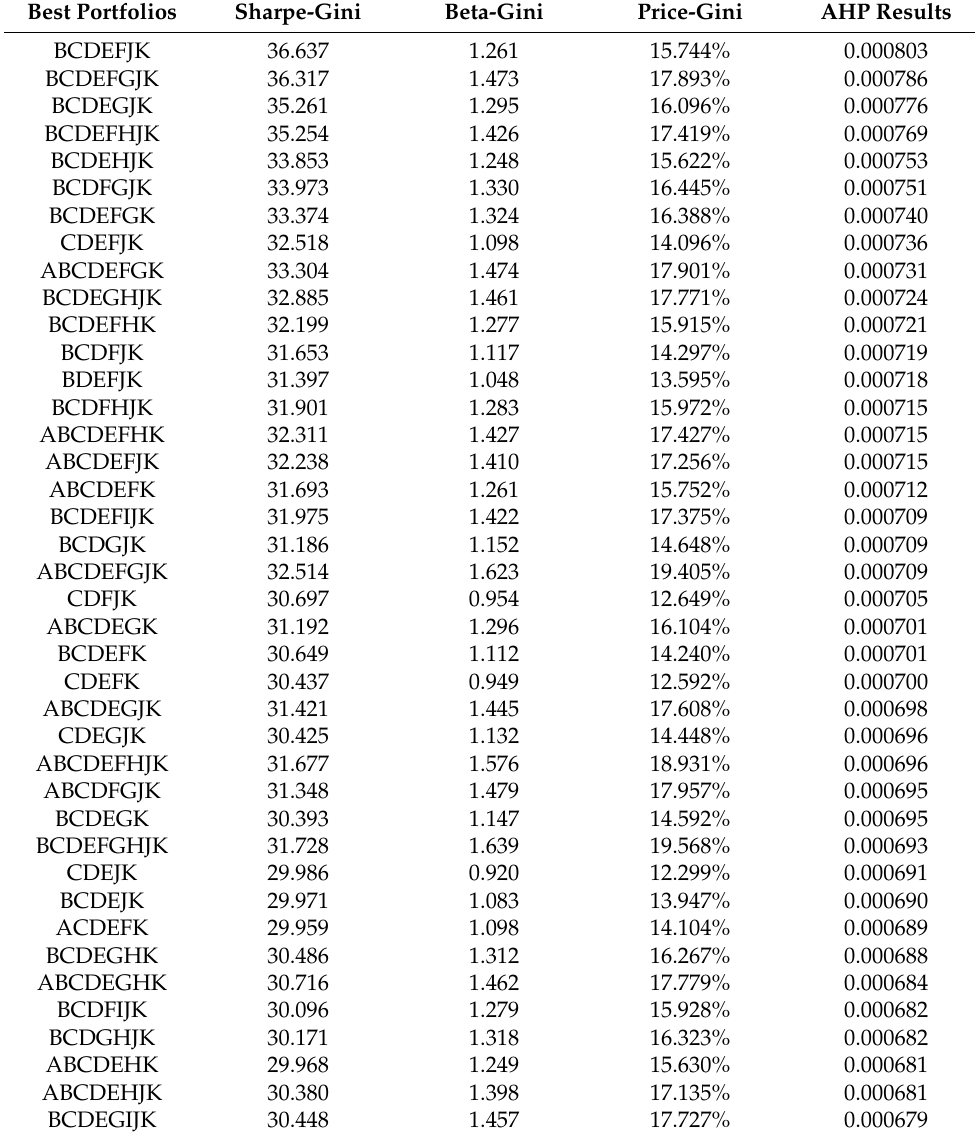
Table 5. Final results for